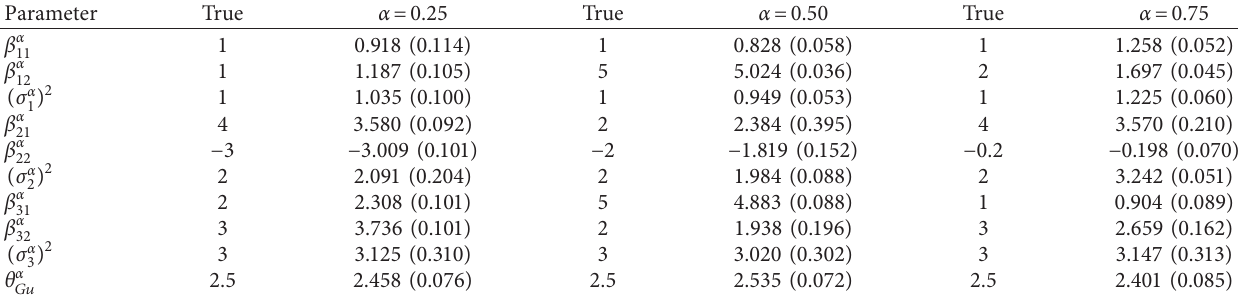
Table 1: Mean and standard deviation of the Bayesian estimate of the Gumbel copula at three quantile levels. Parameter True α � 0.25 True α � 0.50 α �